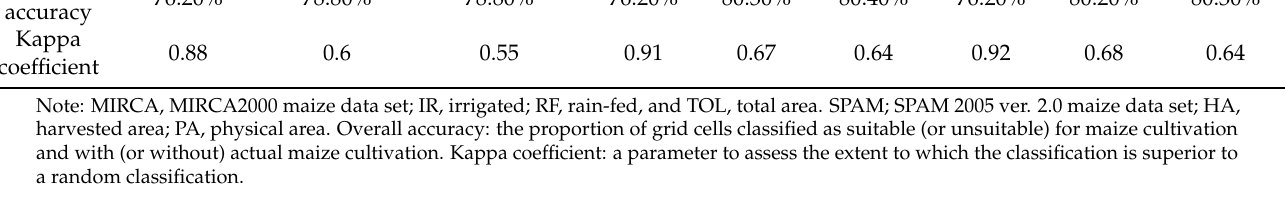
Table 4. Projected total area (mha and percentage) suitable for maize worldwide: present and changes in the